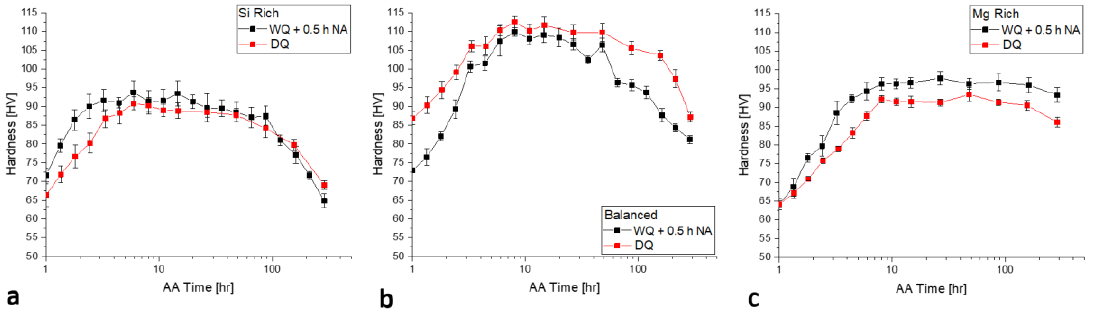
Figure 8. AA hardness evolutions of the high strength alloys in the DQ condition, compared to traditional WQ followed by short (0.5 h) NA, labelled accordingly. Error bars represent 95% confidence.